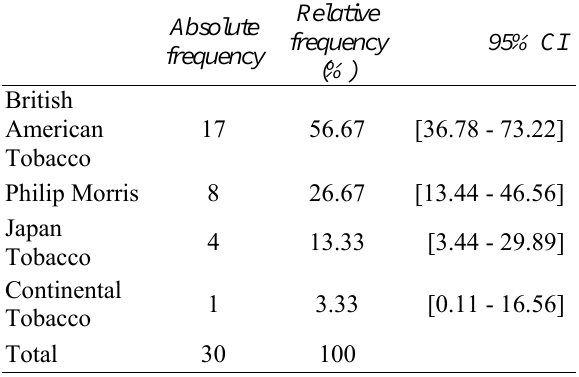
Table 6: Tested cigarettes: distribution of manufacturer Absolute frequency